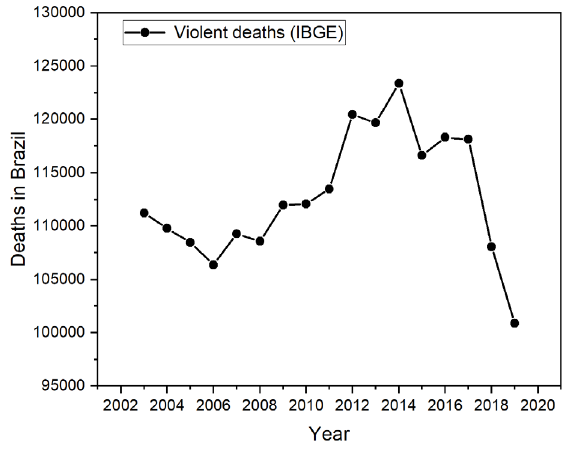
Figure 2. Number of violent deaths in Brazil, between 2003 and 2019. There was a sharp decrease between the years 2017 and 2019, which led to the minimum of the historical series so far.